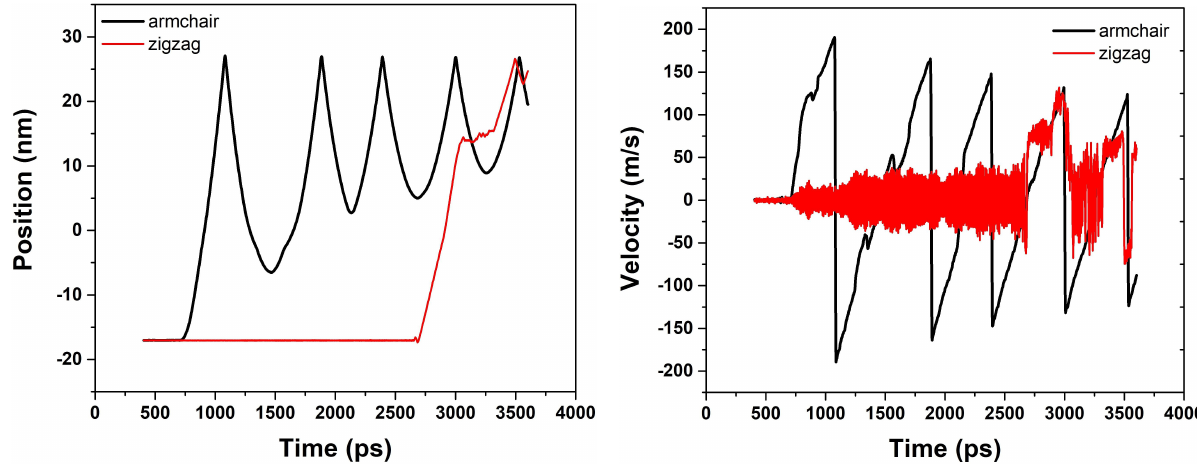
Figure 13: Variation of the movement behaviors with time for the system of armchair chirality and zigzag chirality containing 2 vacancy defects: (a) The position with time. (b) The velocity with time